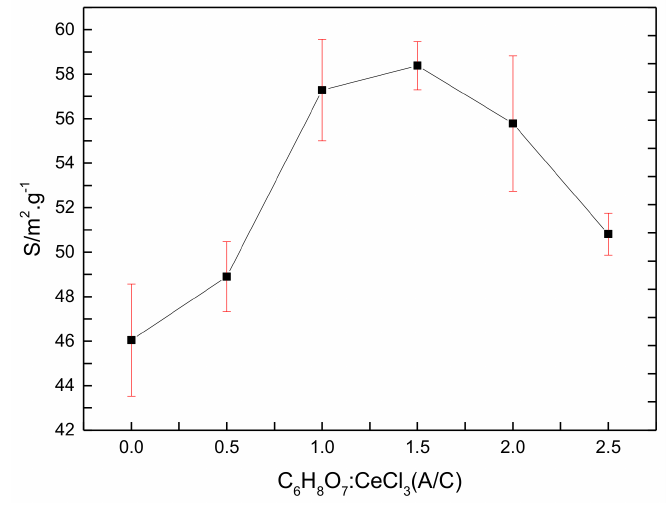
Figure 9. The specific surface area of the CeO 2 products prepared with various (A/C).